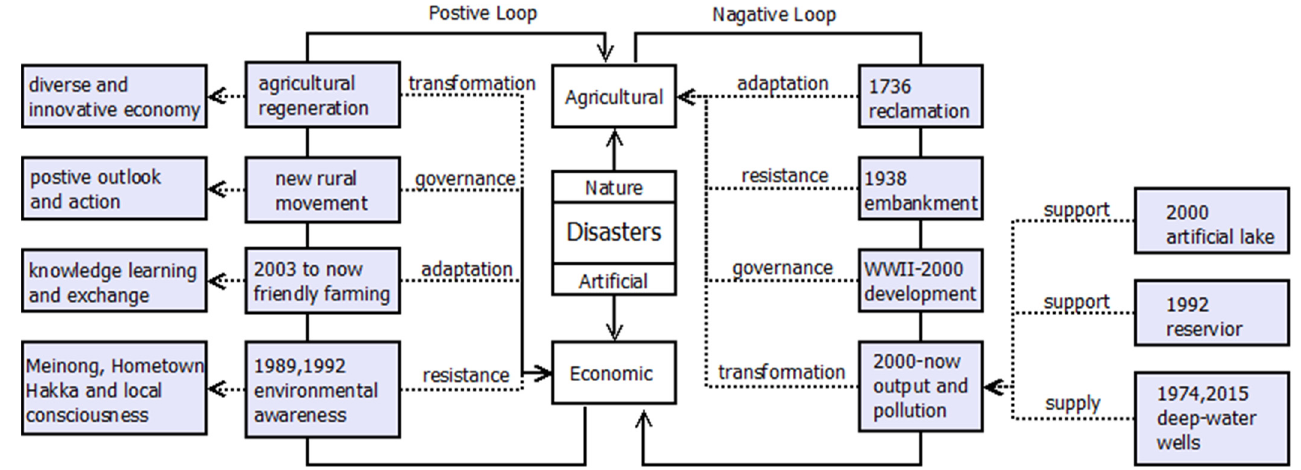
Figure 7. Two loops of disaster duality.